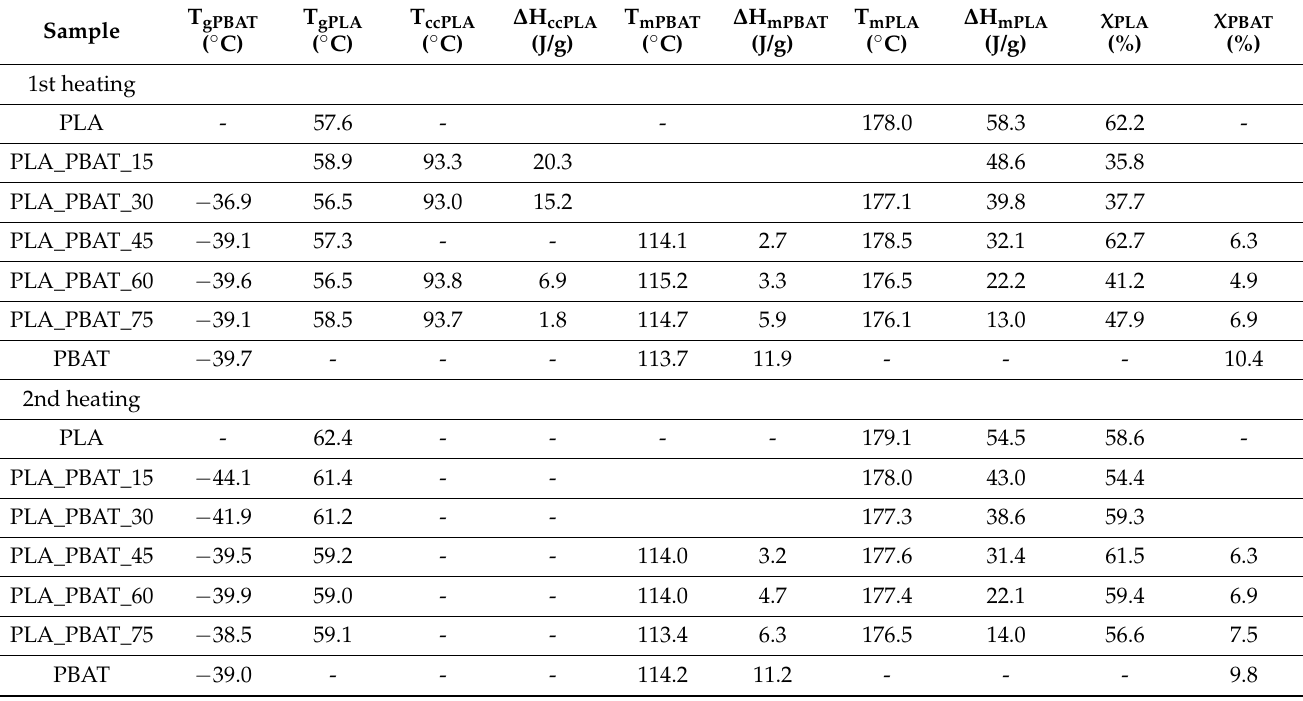
Table 3. Results of the DSC tests on neat PLA, neat PBAT and PLA/PBAT blends (first and second heating